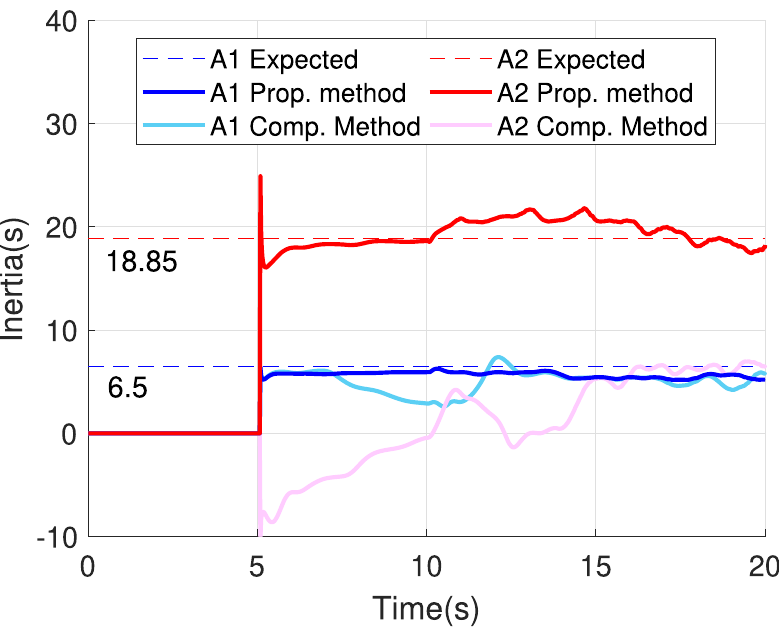
Figure 12. Inertia